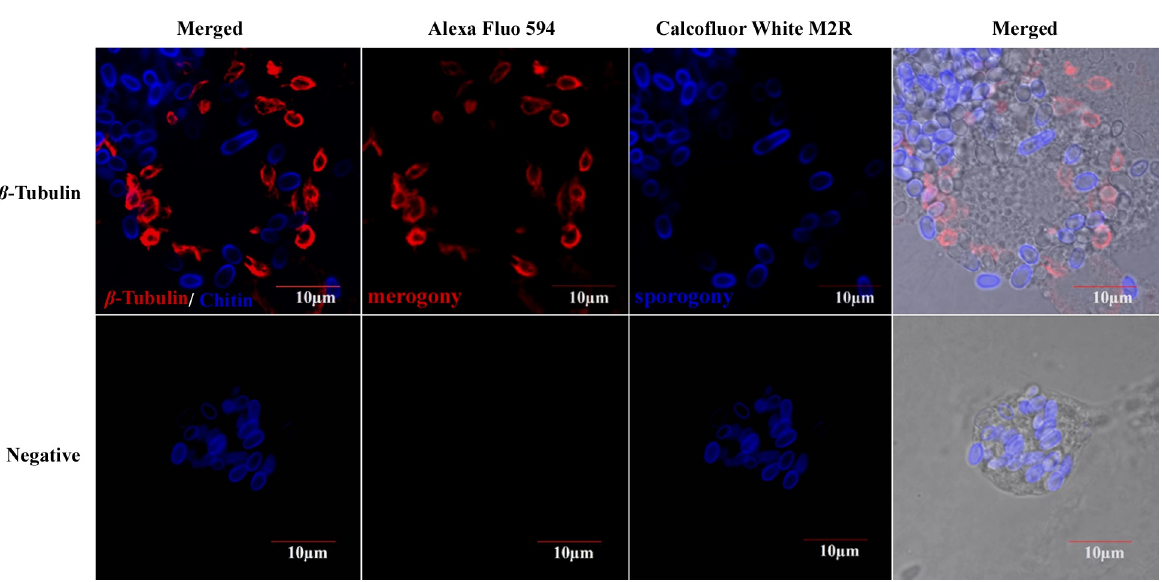
Fig 3. Labeling the merogony phase (red) and the sporogony phase (blue) of microsporidian in N . bombycis -infected BmE culture cells. Based on the absenceor presenceof chitin, parasitesin proliferativephase were labeledby β - Tubulinusing an indirect immunofluorescenceassay, whilecells in sporogonic phase were marked by chitin using 0.1 μ g/mL CalcofluorWhite M2R. N . bombycis infected culture cells were incubatedwith negativeserum used as a negativecontrol. (Bars = 10 μ m).